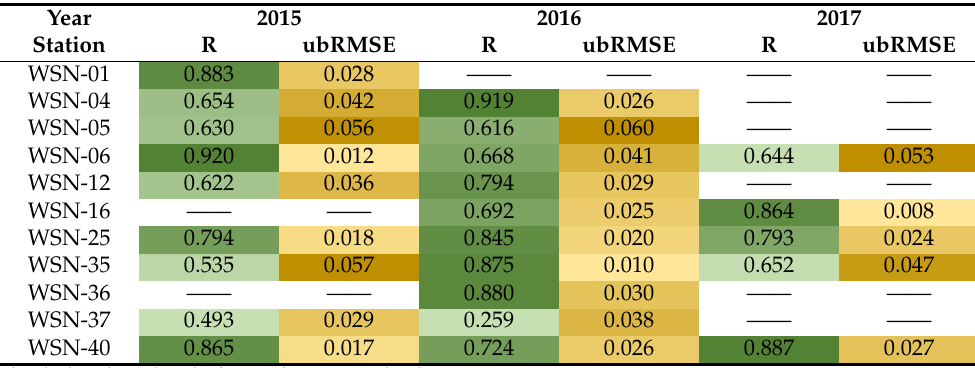
Figure 8. Scatterplots of the Ecological and Hydrological Wireless Sensor Network (EHWSN) obser- vations and the upscaled SM. Table 2. Validation of the upscaled